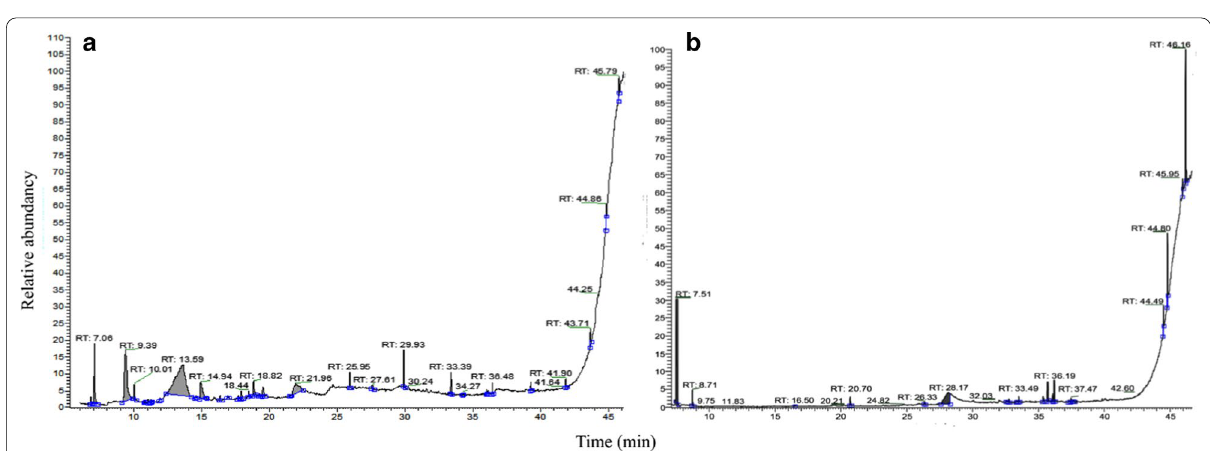
Fig. 2 Chromatograms of the bioactive compounds present in a hot, and b cold acetone extracts of neem